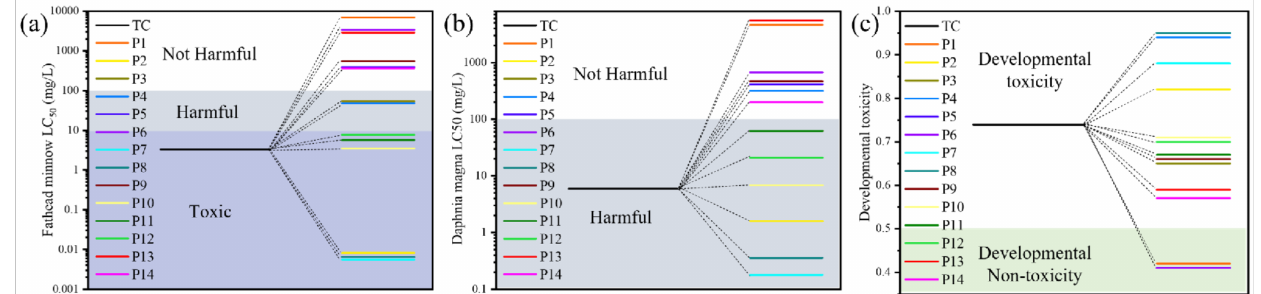
Figure 18. ( a ) Fathead minnow LC 50 ; ( b ) Daphnia magna LC 50 ; and ( c ) developmental toxicity